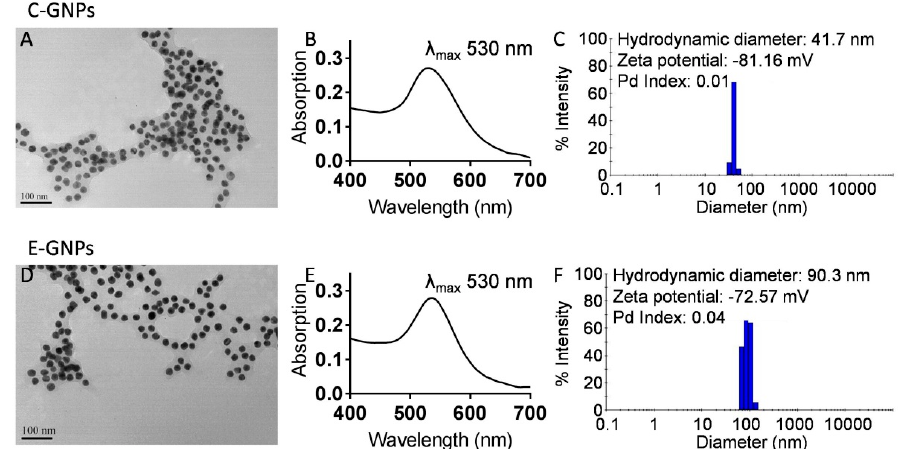
Figure 1. Characterization of citrate-gold nanoparticles (C-GNPs) and EGCG-gold nanoparticles (E-GNPs). ( A ) Transmission electron microscopy (TEM) image of C-GNPs shows that the nanoparticles are spherical in shape and ~25 nm in size. ( B ) The absorption spectrum of C-GNPs showing λ max at 530 nm. ( C ) Dynamic light scattering (DLS) measurement of C-GNPs showing their size distribution, hydrodynamic diameter, and zeta potential. ( D ) TEM image of E-GNPs shows that the nanoparticles are spherical in shape and ~25 nm in size. ( E ) The absorption spectrum of E-GNPs showing λ max at 530 nm. ( F ) Dynamic light scattering measurement of E-GNPs showing their size distribution, hydrodynamic diameter, and zeta